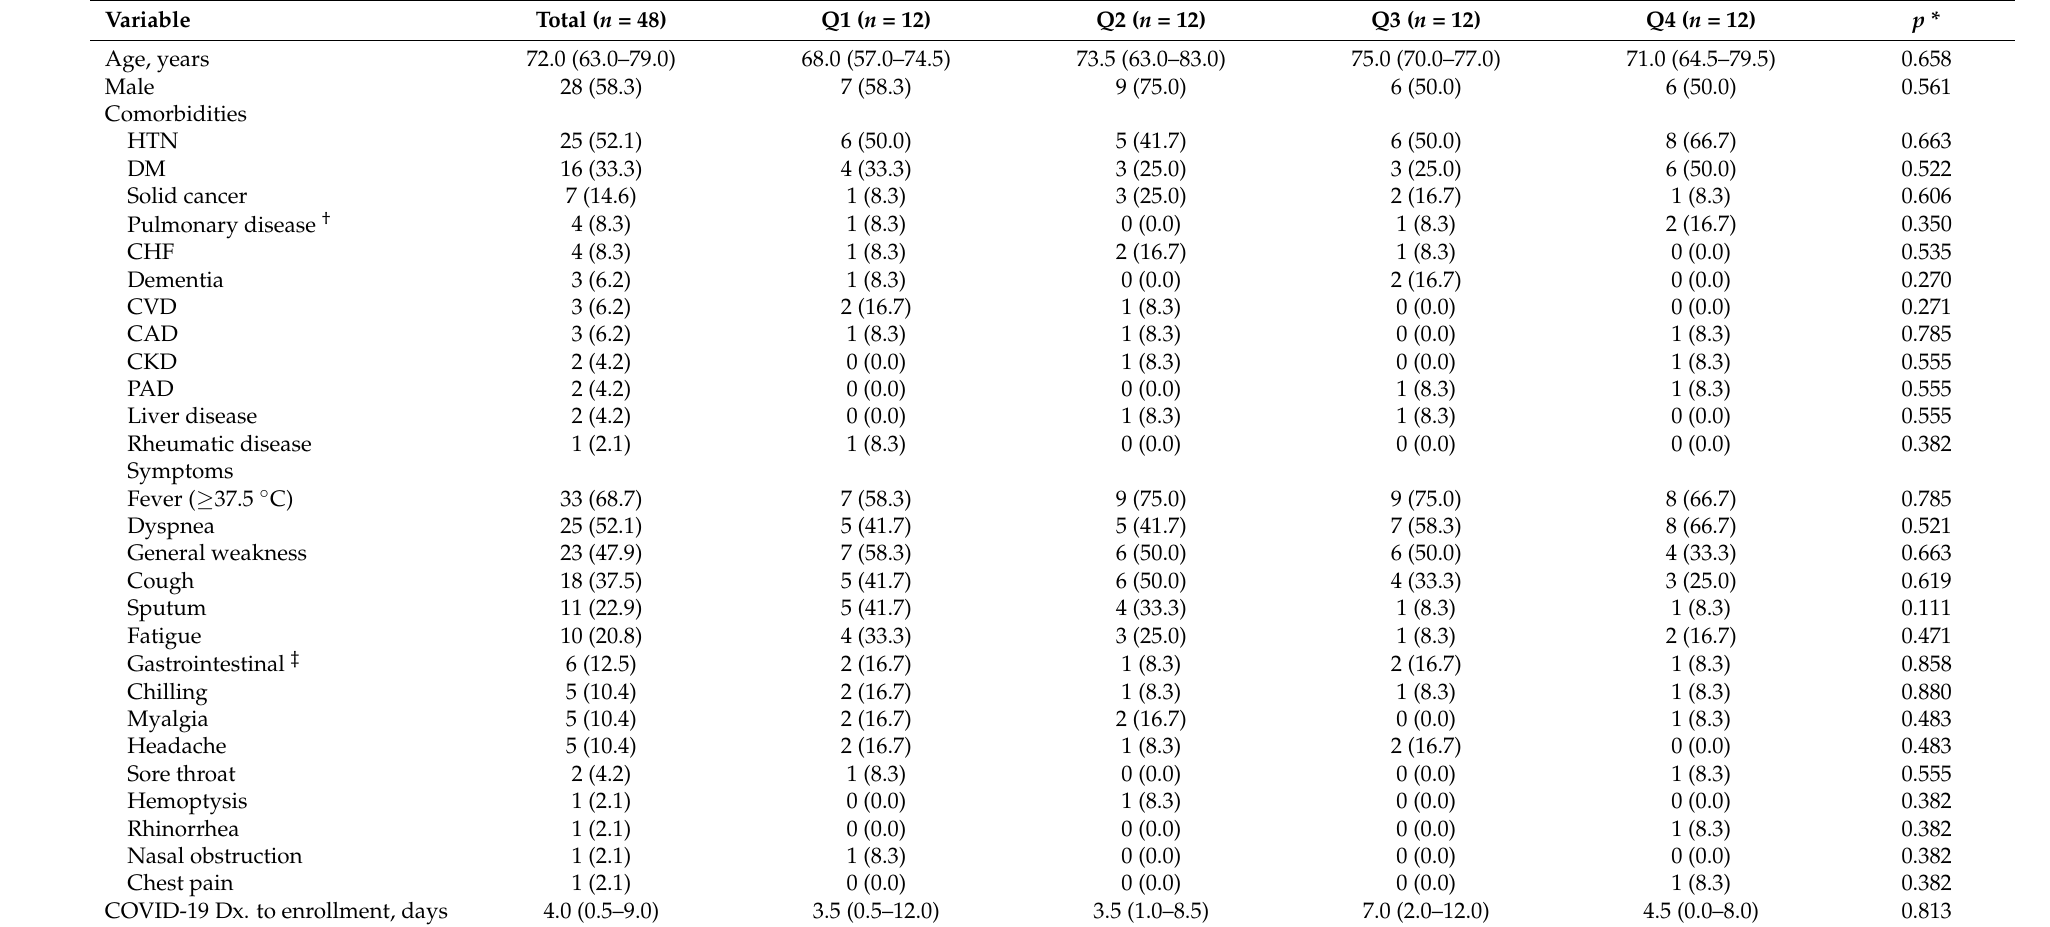
Table 1. Basic characteristics of the study